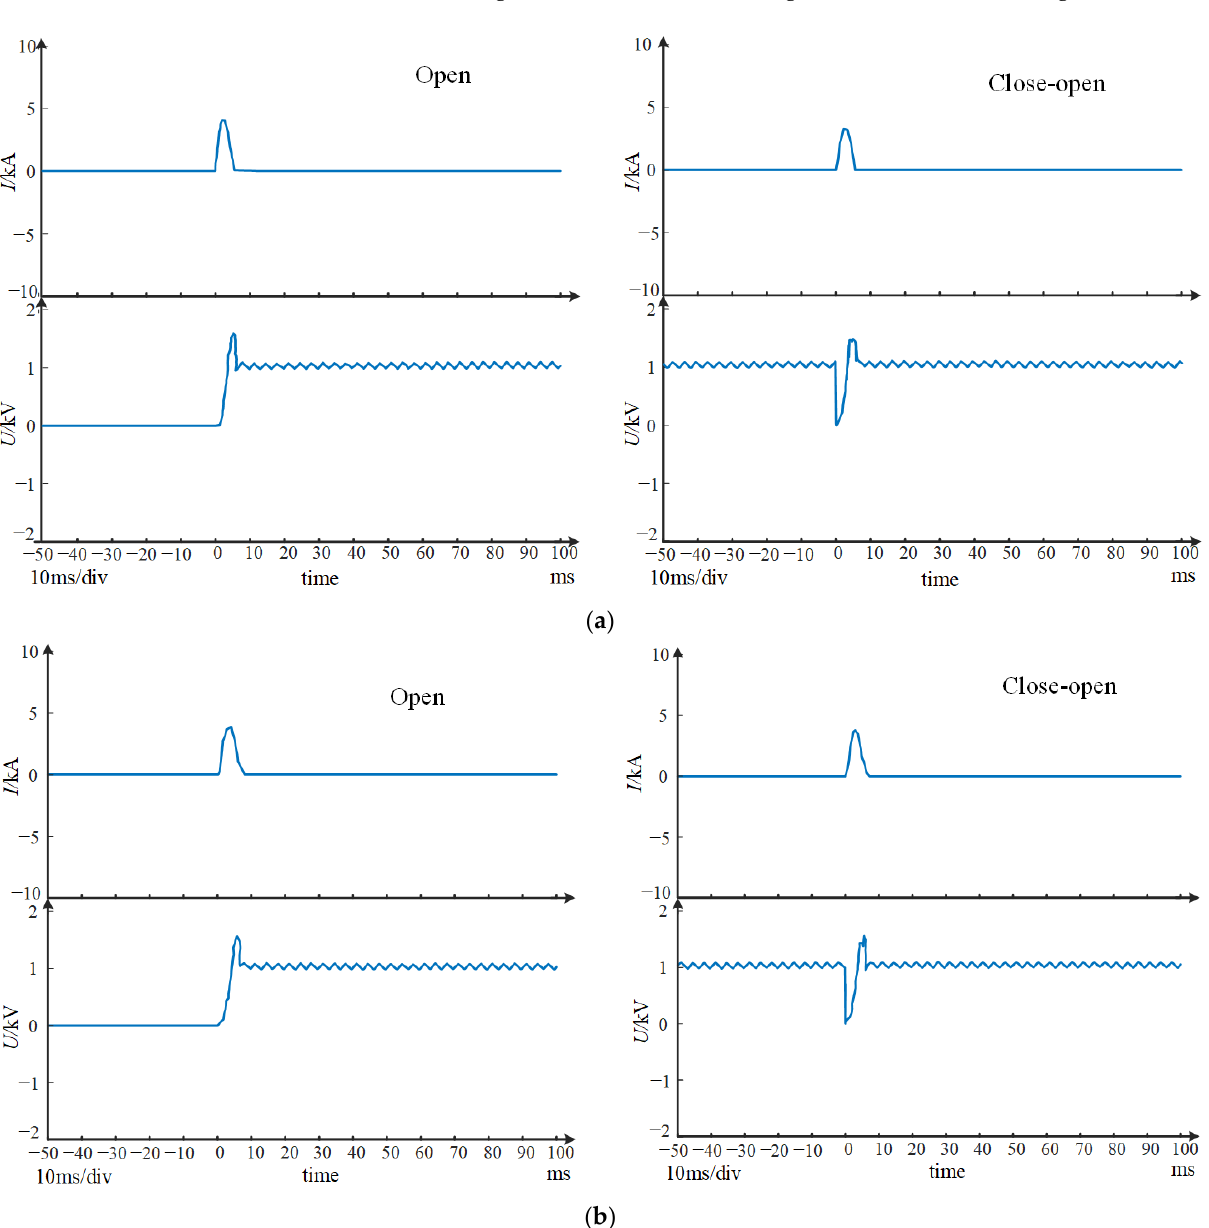
Figure 4. DC breaking test waveform (third party test). ( a ) The waveform of forward connection. ( b ) The waveform of reverse connection.